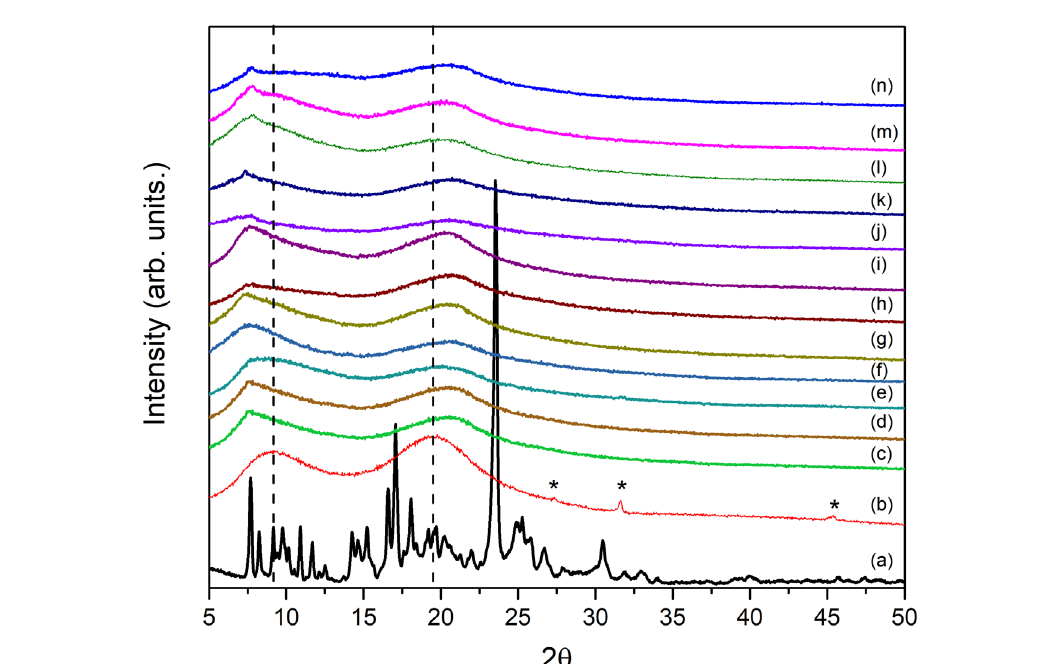
FIGURE 2 - X-ray powder diffraction patterns of DOX (a), HPMC E6 (b), WP-F1 (c), WP-F4 (d), WP-F7 (e), F1 (f), F2 (g), F3 (h), F4 (i), F5 (j), F6 (k), F7 (l), F8 (m), and F9